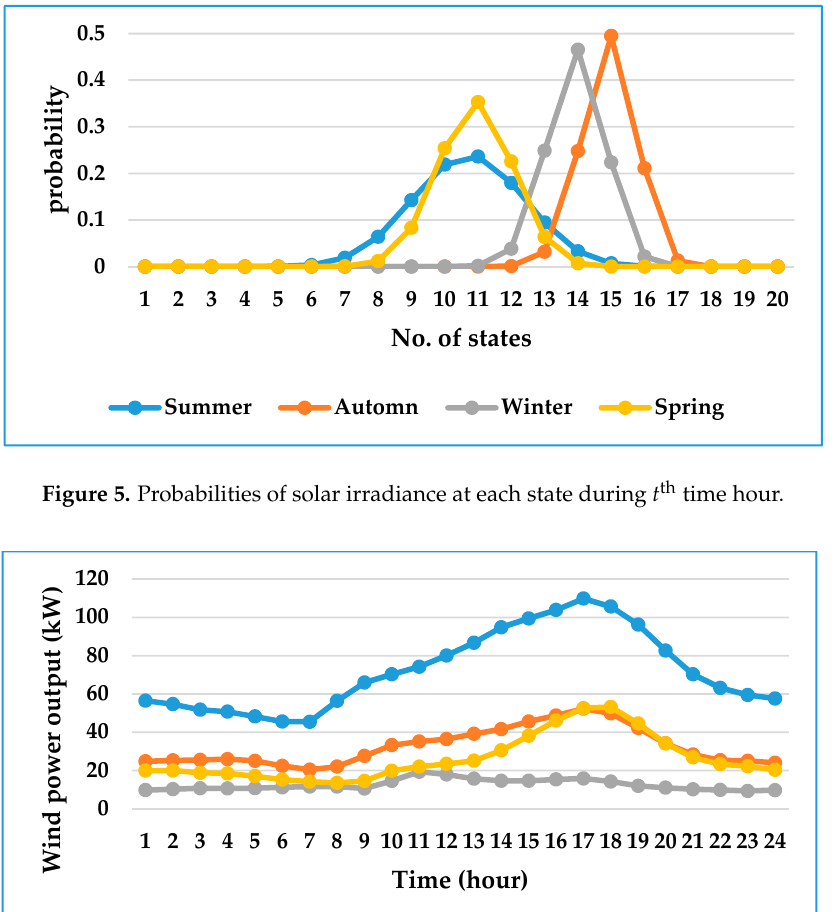
Figure 6. Power output of wind turbine